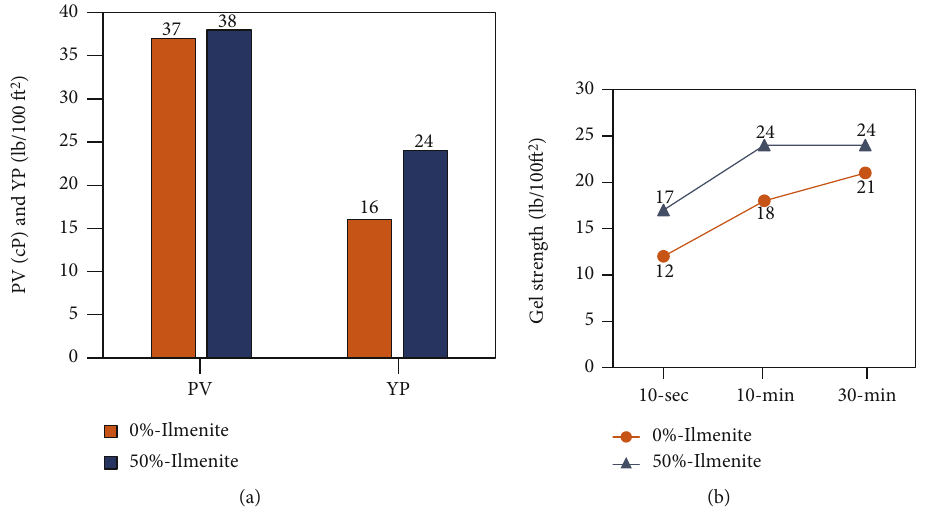
Figure 7: E ff ects of adding 50% ilmenite on rheology at 350 °